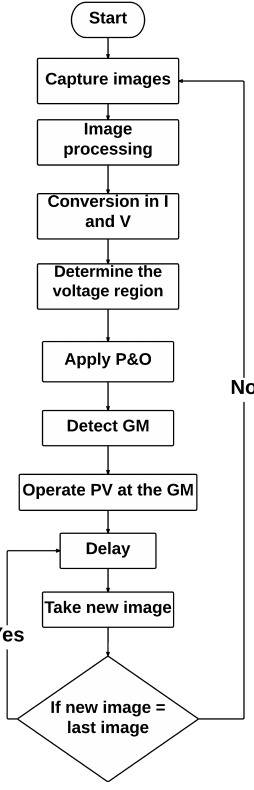
Figure 3. Flowchart of the proposed